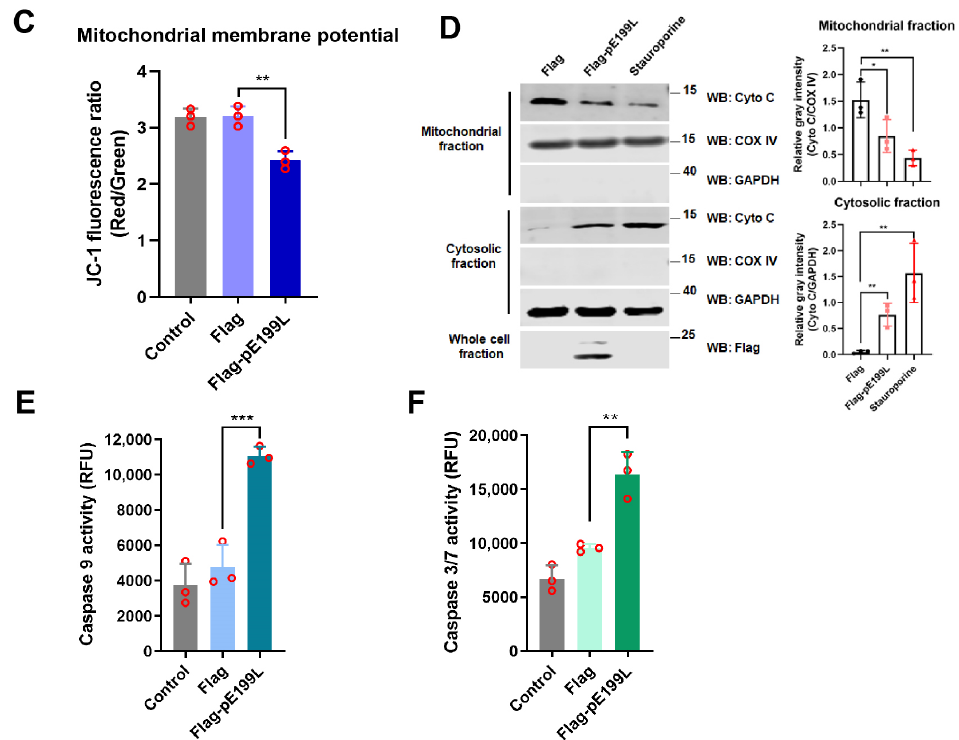
Figure 4. ASFV pE199L triggers the mitochondrial apoptotic pathway. ( A ) Analysis of the morphological changes in mitochondria. HeLa cells were transfected with pGFP-pE199L or GFP for 36 h and were then stained with an antibody against mitochondrial outer membrane 20 (Tom20). The inset images display the typical tubular mitochondrial network in the control and GFP group and the collapsed mitochondria (excessive fission) in GFP-pE199L-expressing cells. Green fluorescence represents GFP or GFP-pE199L while blue indicates nucleus stained by DAPI and red represents mitochondrial stained by Tom20. Inset scale bars: 5 µ m; other scale bars: 10 µ m. ( B ) Real-time confocal images of HeLa cells co-expressing GFP-pE199L (green) and DsRed-mito (orange). Time stands for relative time (hh:mm). Scale bar: 50 µ m. Red arrowhead: apoptotic cell. ( C ) Detection of the mitochondrial membrane potential. HeLa cells were transfected with pFlag-E199L or pFlag for 36 h, stained with JC-1, and then 10,000 cells were quantified by flow cytometry as described in Materials and Methods. ( D ) Western blotting analysis of the translocation of cytochrome C (cyto C) in fractionations from HeLa cells transfected with pFlag-E199L or pFlag or treated with staurosporine as a positive control (left). COX IV and GAPDH were respectively used as the internal controls of the mitochondrial or cytosolic fractions. Ratios of Cyto C and COX IV or GAPDH are shown as the mean ± SD values from 3 independent experiments (right). The gray density of the protein bound was measured by Image J software. ( E , F ) Detection of caspase-9 and caspase-3/7 activation. HeLa cells were transfected with pFlag-E199L or pFlag for 36 h and then caspase substrates were added, respectively. The activities of caspase-9 ( E ) and caspase-3/7 ( F ) were measured using an Enspire multiscan spectrum reader. The significance of differences between the groups was determined by an ordinary ANOVA test with Dunnett (* p < 0.05, ** p < 0.01, *** p <